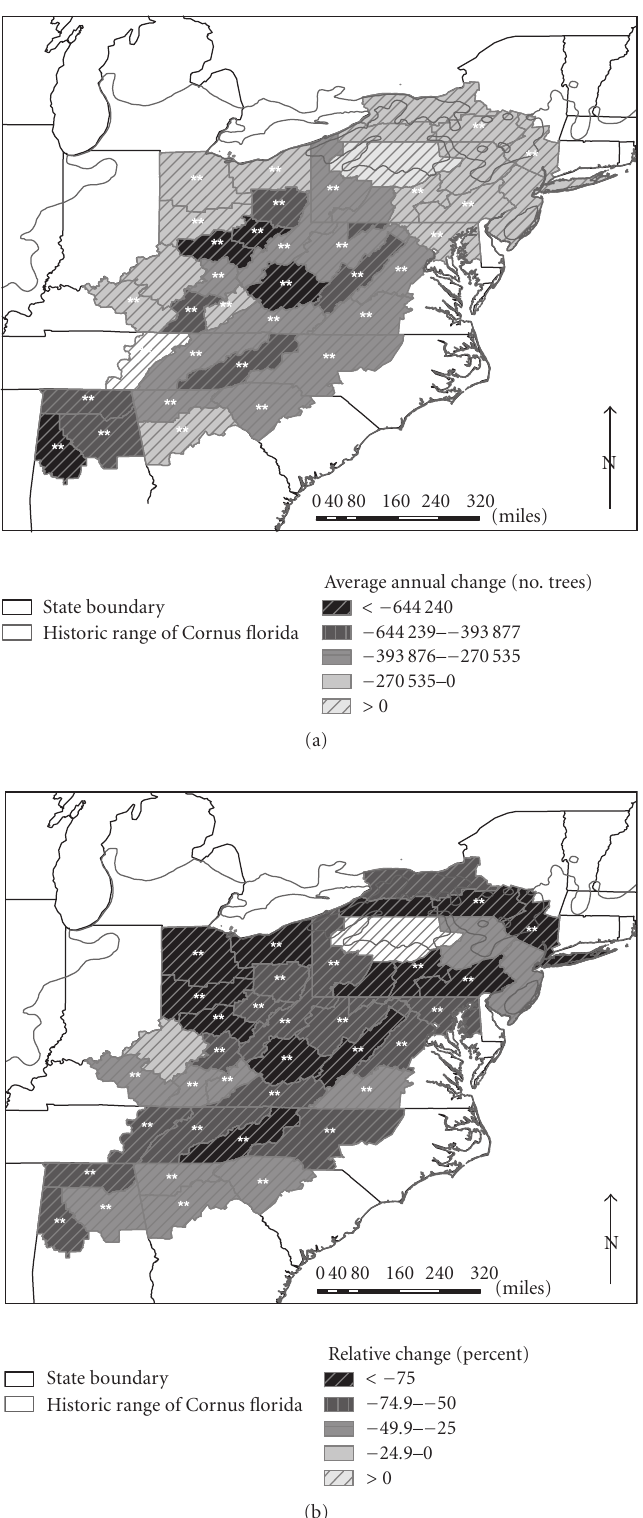
Figure 3: Estimates of (a) average annual county-level change and (b) total relative change of dogwood tress for all FIA regional units comprising the Appalachian ecoregion. ∗∗ Denotes a significant di ff erence between Time 1 and Time 2 (alpha = 0.05). State boundary shapefile is provided by ESRI. FIA Unit boundary shapefile is provided by Joe McCollum, USDA Forest Service, Southern Research Station Forest Inventory &